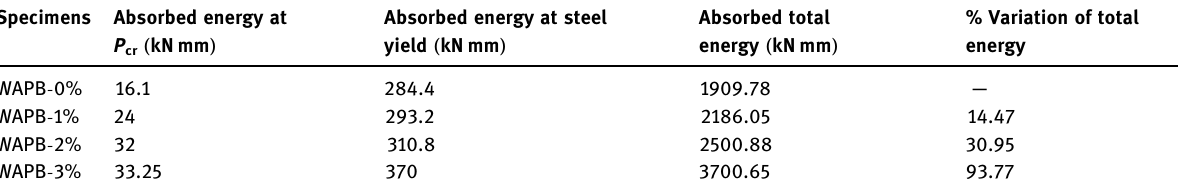
Absorbed energy at